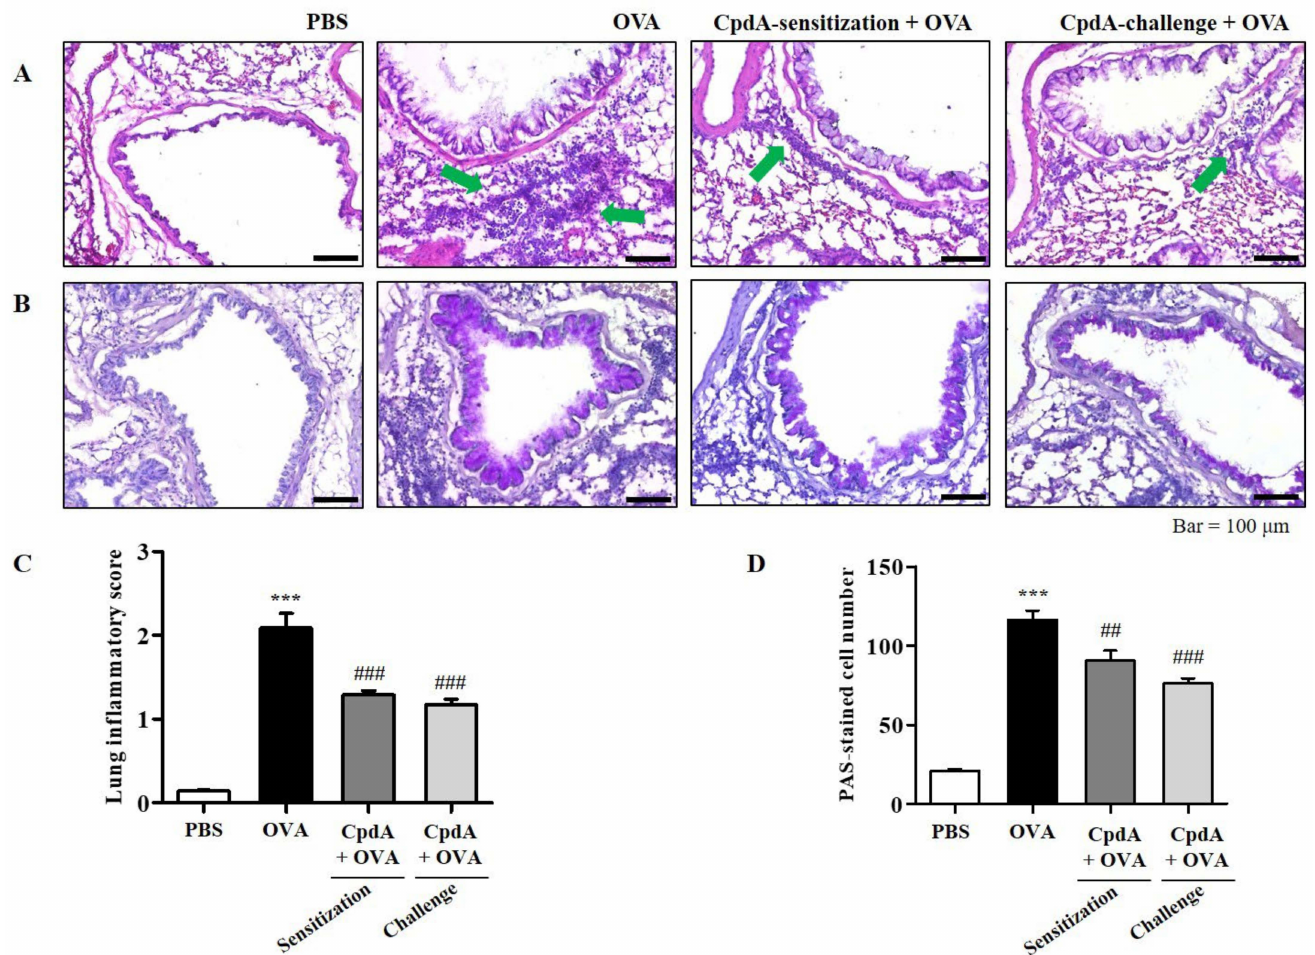
Figure 3. Compound A protects against airway inflammation and mucin secretion in FFA4-WT mice. ( A ) Panels show H&E-stained sections of lung tissues from the PBS group, OVA group, and compound A-treated OVA groups (before sensitization or before challenge). Small navy-blue dots around the bronchioles indicate eosinophils. Eosinophils are accumulated around bronchioles in the OVA group (green arrows). ( B ) Panels show PAS/hematoxylin-stained sections of lung tissues from the PBS group, OVA group, and compound A-treated OVA groups (before sensitization or before challenge). In PAS staining, mucin is stained as a purple color. Darker and thicker purple coloring is observed surrounding the bronchiole in the OVA group compared to the PBS group. ( C ) Lung inflammation was semi-quantitatively evaluated; histological findings were scored as described in Section 4. ( D ) Mucous production was measured by counting the number of PAS-positive cells per mm of bronchiole ( n = 5 per group). Values represent the means ± SEM ( n = 5). *** p < 0.001 vs. the PBS-treated group, ## p < 0.01, ### p < 0.001 vs. the OVA-treated